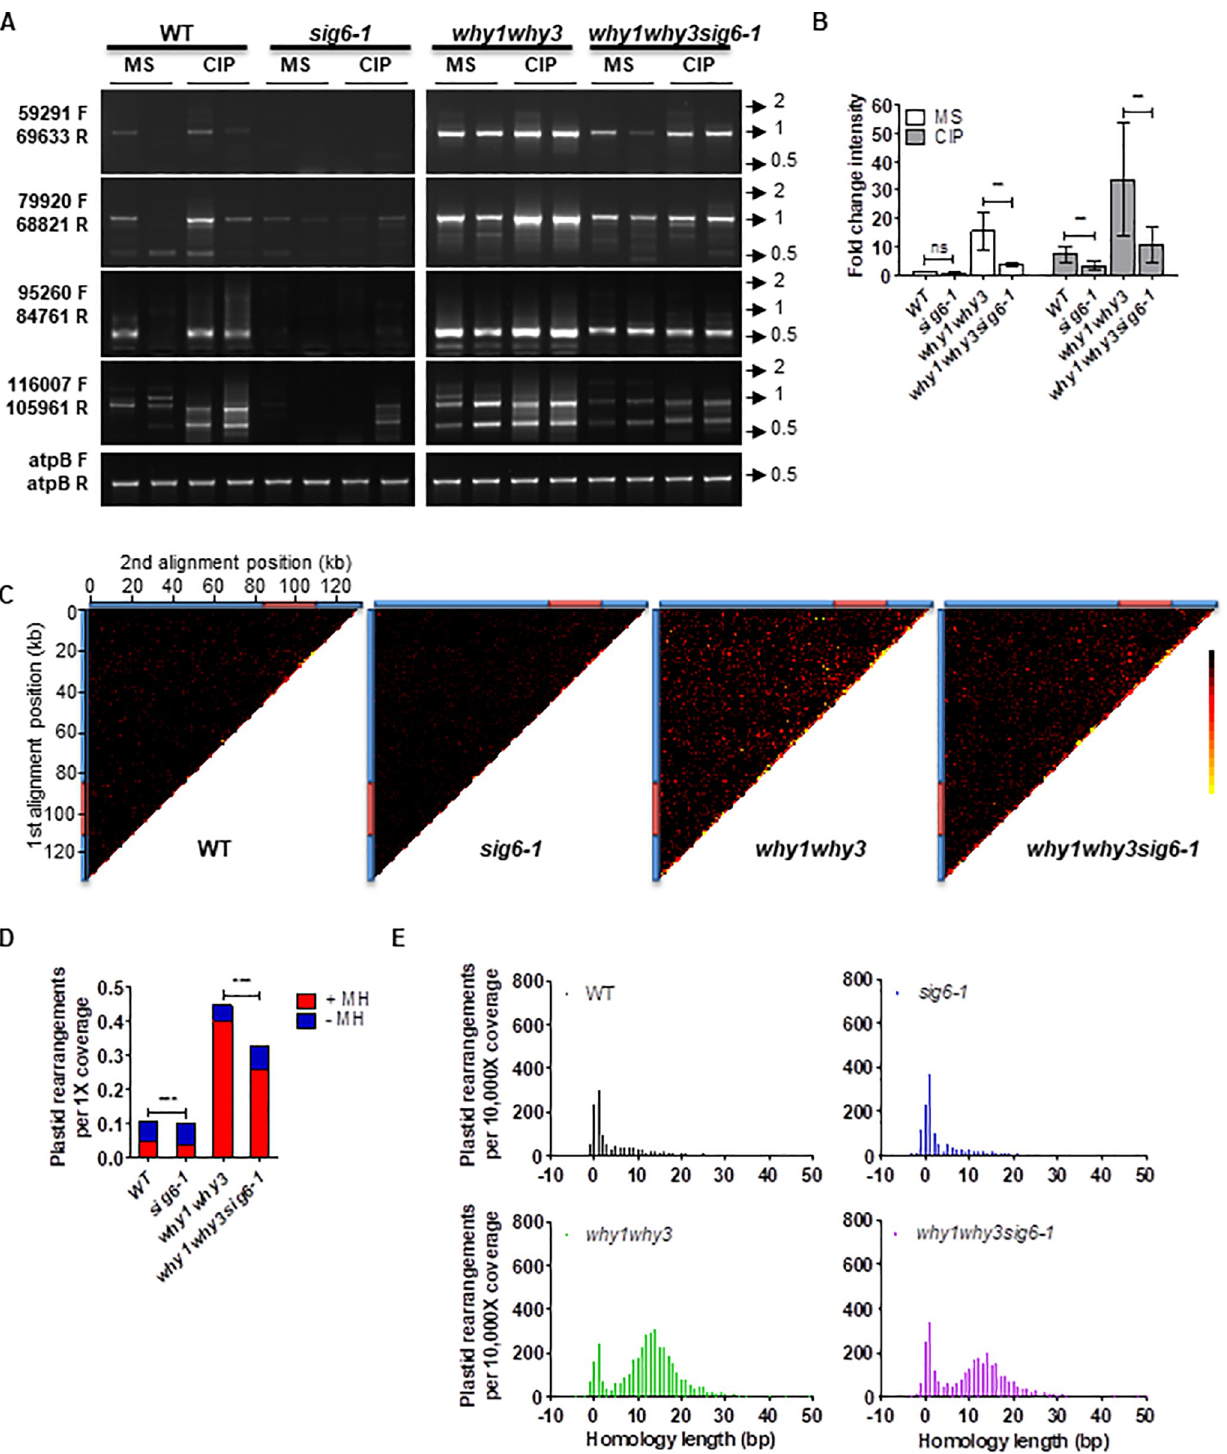
Fig 1. SIG6-dependent transcription induces plastid genome instability. (A) Representative PCR reactions from a total of 8 to evaluate the abundance of ptDNA rearrangements (number and intensity of bands represent rearranged DNA), carried out on total leaf DNA of wild-type (WT), sig6-1 , why1why3 , and why1why3sig6-1 plants grown 14 days after germination (DAG) on solid MS alone or with 0.5 μ M CIP. PCR experiments were performed at least three times with duplicate samples. Low cycle amplification of the atpB plastid gene was used as a loading control. Primers pairs used for PCR reactions are indicated on the left side of the gels. Arrows and numbers on the right side of the gels represent the position and size of the DNA ladder bands in kb. (B)